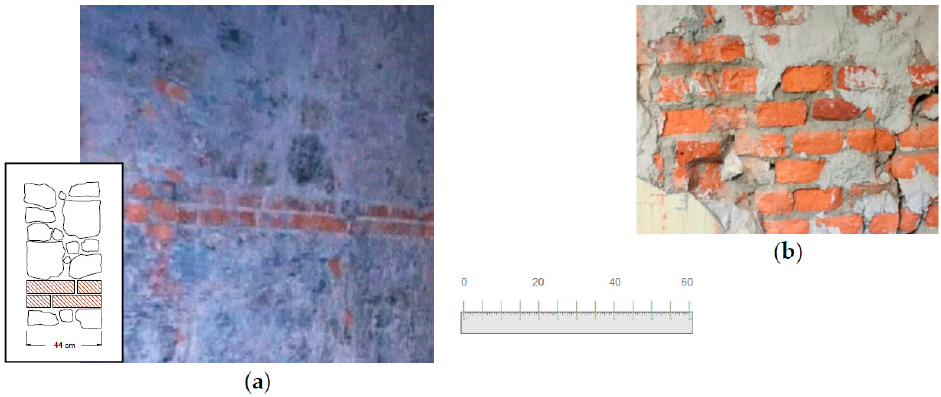
Figure 3. Masonry typologies of Building No. 2: ( a ) Stone work; ( b ) Brickwork, [dimensions in cm].